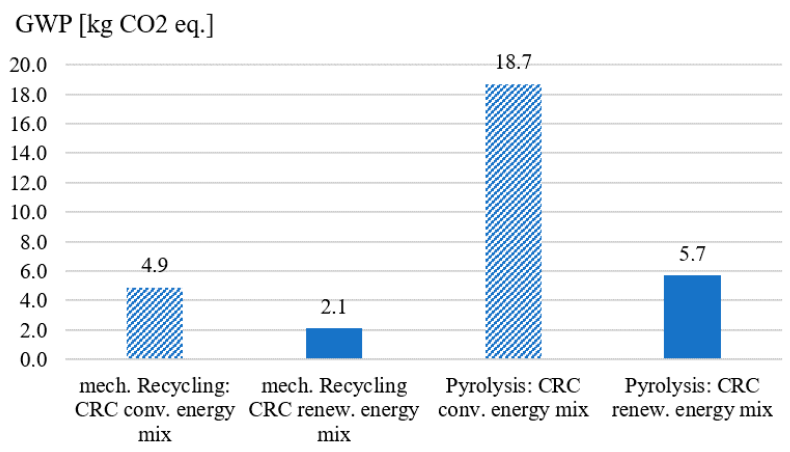
Figure 10. Using renewable energy mix for mechanical recycling and pyrolysis.